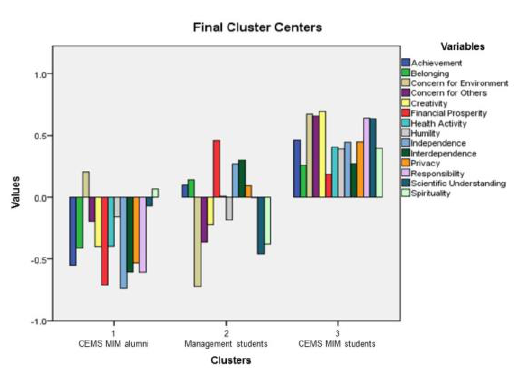
Figure 1. Cluster Analysis of Life Values Compared to the students, alumni show lower degree of importance in the majority of the life values.